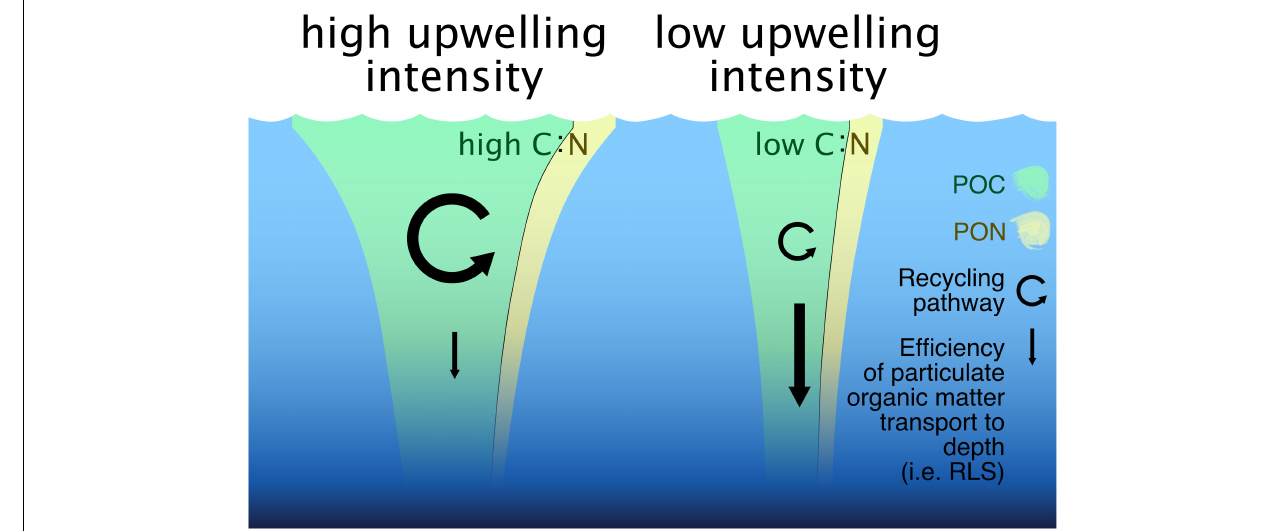
FIGURE 6 | Scheme depicting the effects that upwelling intensity had on carbon sequestration-relevant parameters in our high and low upwelling scenarios. It visualizes the strength and C:N ratio of the export flux (POC ST :PON ST ), as well as the arrow size indicating strength of the recycling pathway and the efficiency of particle transport to depth. Note that we put more emphasis on the difference between POC:PON ratios than on the quantitative PON difference between high and low upwelling intensities. It should also be noted that the effects depicted here only reflect the initial responses to artificial upwelling in oligotrophic waters. They do not cover the ultimate fate of the upwelled inorganic nutrients and hence do not represent the long-term potential for carbon